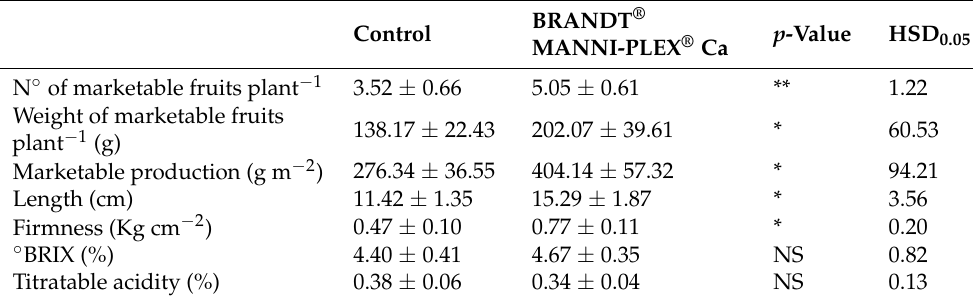
Table 3. Effect of BRANDT ® MANNI-PLEX ® Ca application on the production components in pepper plants and some components of the quality of pepper fruits at harvest. BRANDT ® p -Value HSD Control MANNI-PLEX ® Ca